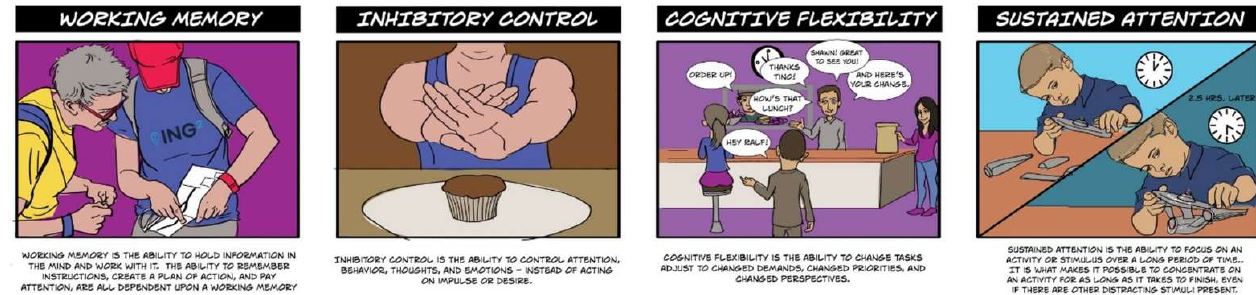
Figure 3. Executive function tests and how they relate to daily activities. (Illustration by Stephen Somers, Milwaukee, WI, USA).